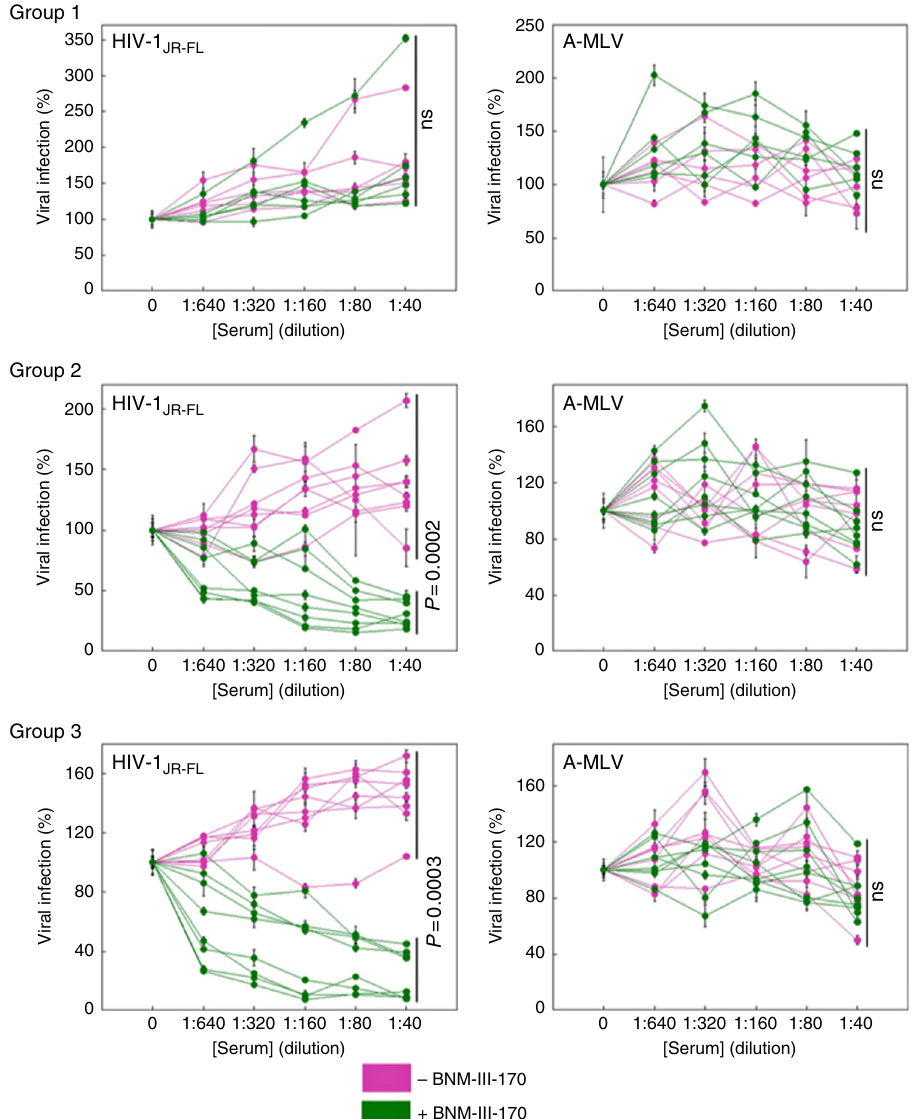
Fig. 2 CD4mc-dependent HIV-1 neutralization by immunized monkey sera. Monkeys were immunized with either human serum albumin (HSA) (Group 1) or the Clade C HIV-1 CH505 gp120 (Groups 2 and 3). In the experiments shown in the green curves, recombinant HIV-1 encoding luciferase and pseudotyped with the heterologous Clade B HIV-1 JR-FL Env (left panels) or with the control amphotropic murine leukemia virus (A-MLV) Env (right panels) was incubated with 20 μ M BNM-III-170 for 30 min at 37 °C; in the experiments shown in the magenta curves, the viruses were incubated with the equivalent volume of DMSO under the same conditions. The viruses were then incubated for 30 min at 37 °C with the indicated dilution of sera from the immunized monkeys (collected on the day of SHIV-C5 Challenge 1). The virus-serum mixtures were added to Cf2Th-CD4/CCR5 cells and, 48 h after continuous incubation at 37 °C, the cells were lysed and luciferase activity measured. The percentage of luciferase activity (which re fl ects the level of virus infection) relative to that seen for viruses without added serum is shown. The means and standard deviations of values obtained from triplicate assays are shown. Differences between the sets of curves obtained in the absence and presence of BNM-III-170 were evaluated for statistical signi fi cance using the statmod software package for R (http://bioinf.wehi.edu.au/software/compareCurves). (ns not signi fi